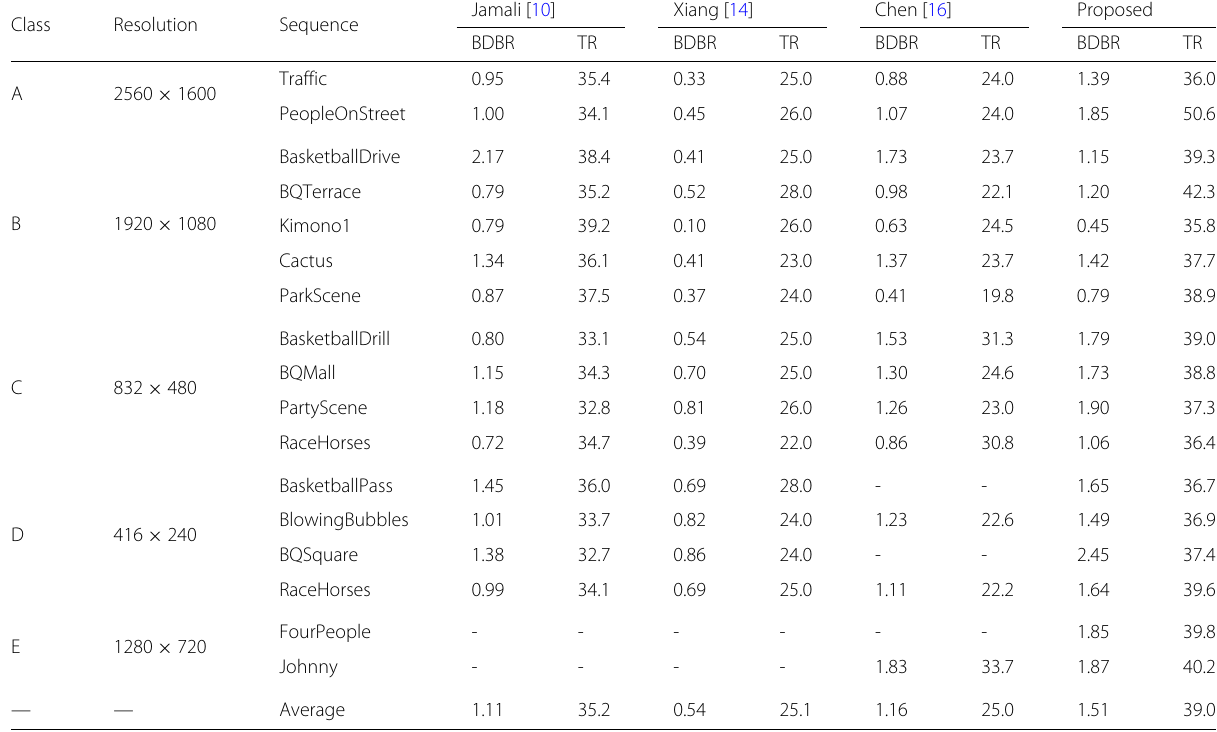
Table 4 Comparison of the proposed fast coding mode decision algorithm against the existing algorithms and HM 13.0